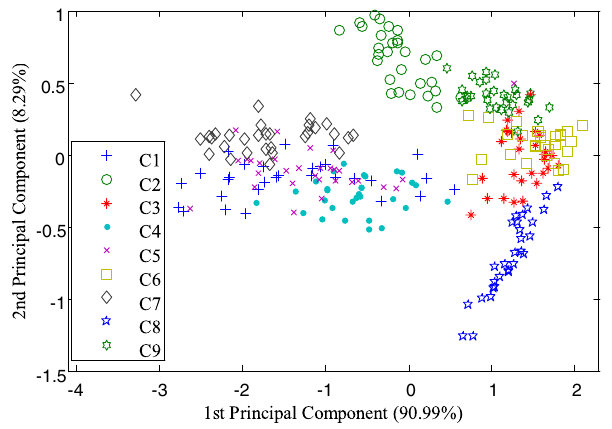
Fig. 2. Plot of ¯rst two principal components (PCs) obtained by PCA of NIR spectra.